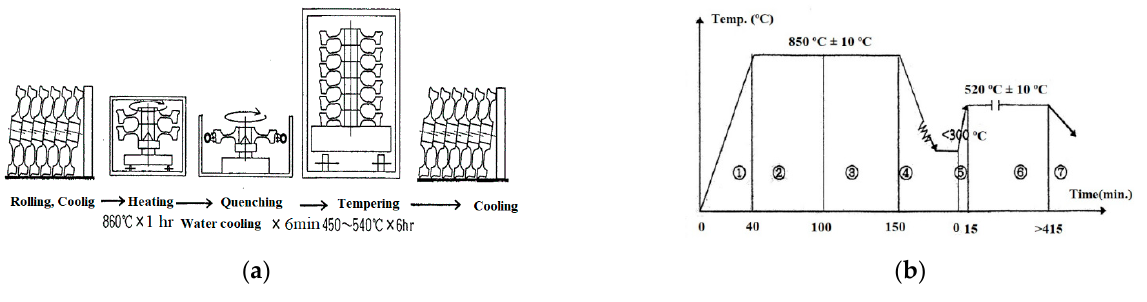
Figure 1. Manufacturing process of the wheel: ( a ) heat treatment process; ( b ) temperature varia ‐ tion. Table 1. Chemical composition of rail steel (wt.%).